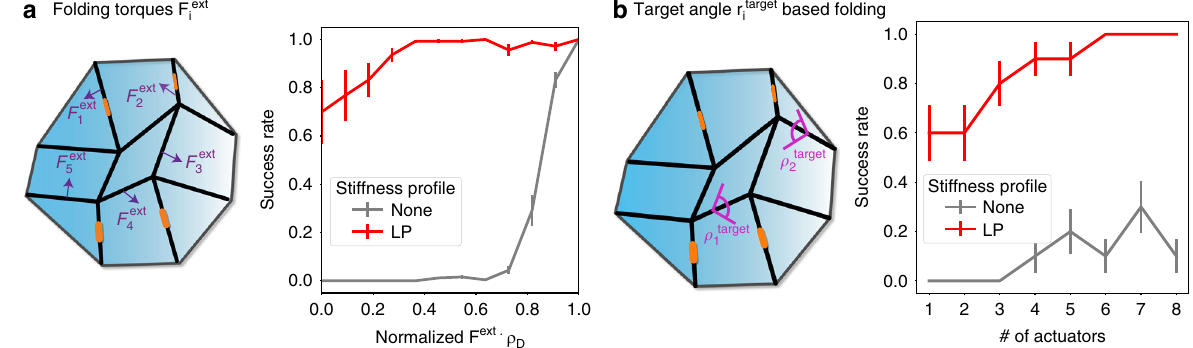
Fig. 4 Sheets with stiff creases dramatically improve folding for a wide range of external forces applied to speci fi c creases. We consider folding by ( a ) different folding torques F ext i or ( b ) springs that target desired fold angles ρ target i for different creases i . a Forces F ext i are much more likely to fold into the desired mode with stiff creases (red data) (predicted by linear programming) than with freely folding creases (gray). Even folding forces F ext i very poorly aligned with the desired pathway ( ρ D ) i result in the desired pathway (averaged over 5 random 16-vertex patterns, 100 random F ext i for each data point). b Patterns folded using springs of given target angle ρ target i